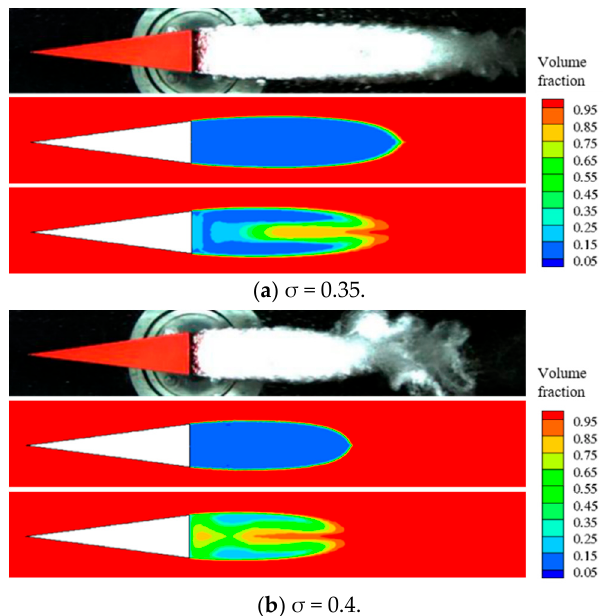
Figure 12. Cavity volume behind wedge (top: experiment, middle: incompressible flow solver; bottom: compressible flow solver).